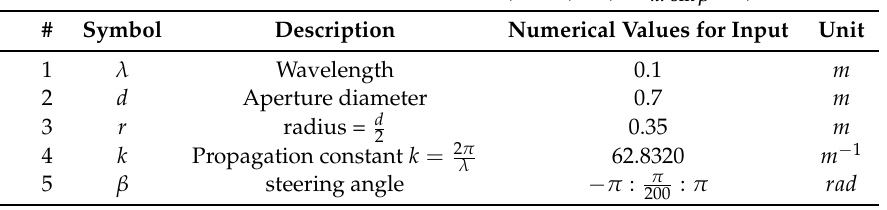
Table 2. Linear array antenna [5].